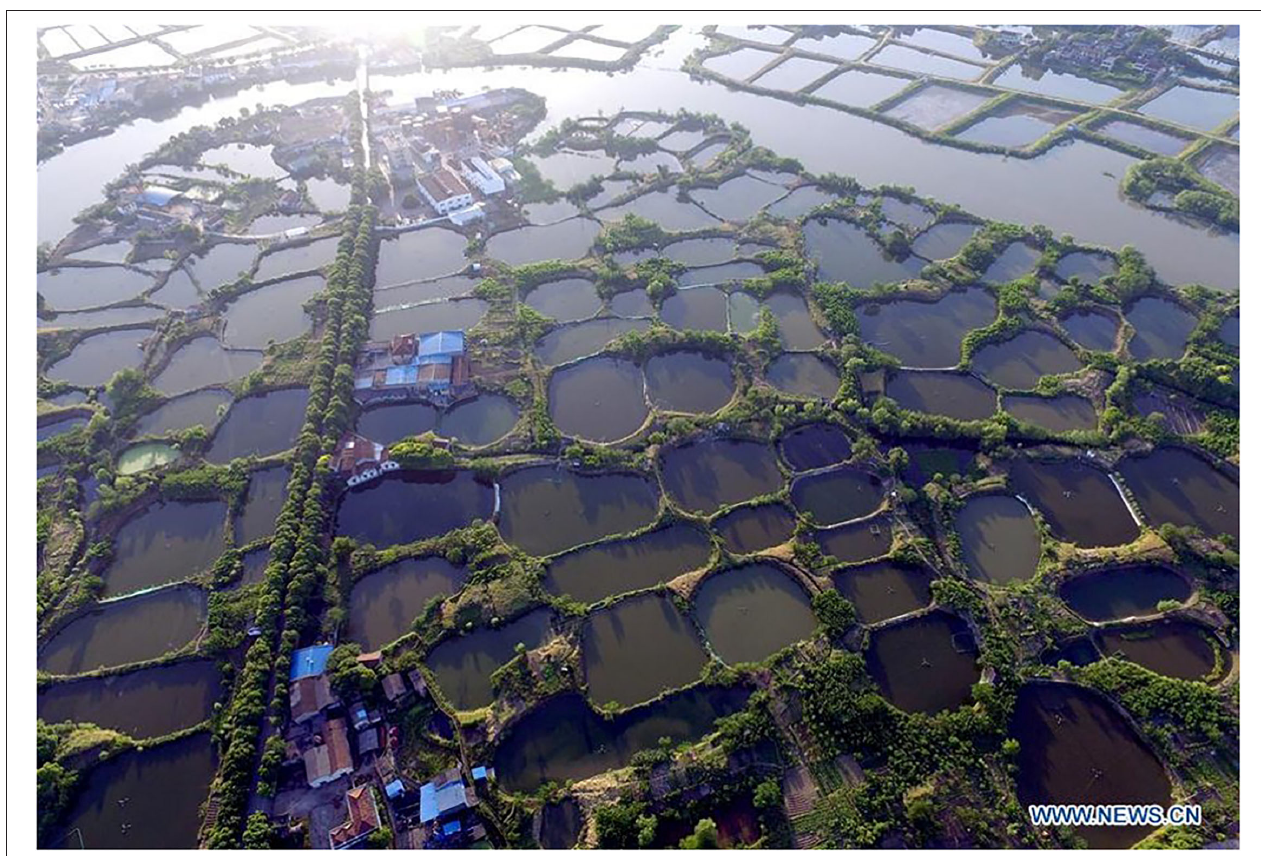
FIGURE 8 | The Zhejiang Huzhou Mulberry-Silkworm-Fish Pond Aquaculture Ecosystem in China is estimated to be more than 2,500 years old existing to today. It has been designated by the FAO (2019) as a “Globally Important Agricultural Heritage System.” Photo taken from: